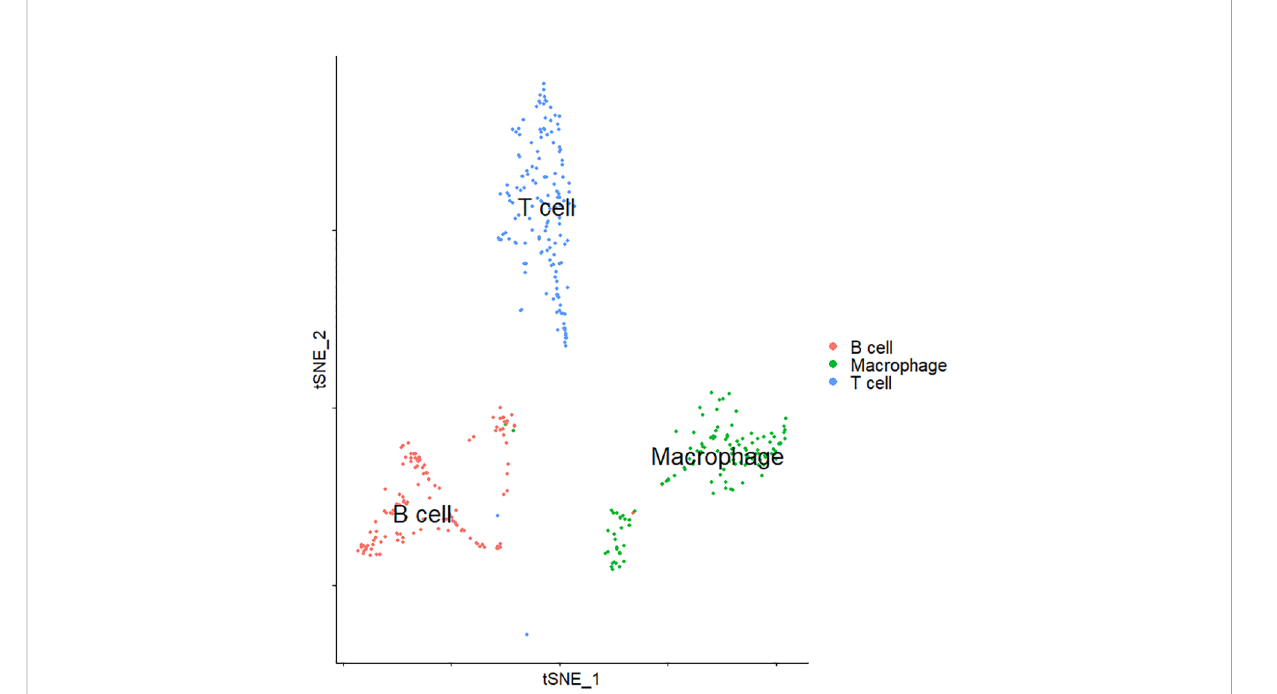
FIGURE 6 t-SNE visualization of the cluster of immune cells. t-SNE, t-distributed stochastic neighbor